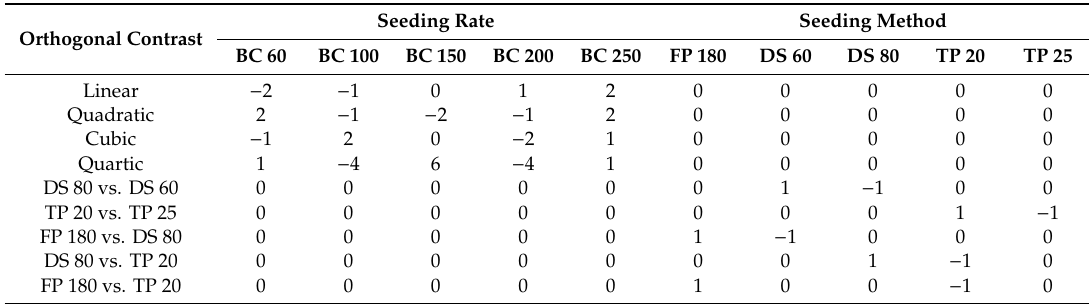
Table 3. Coe ffi cients for orthogonal contrasts used in the single-degree-of–freedom analysis of variance for seeding rate / seeding